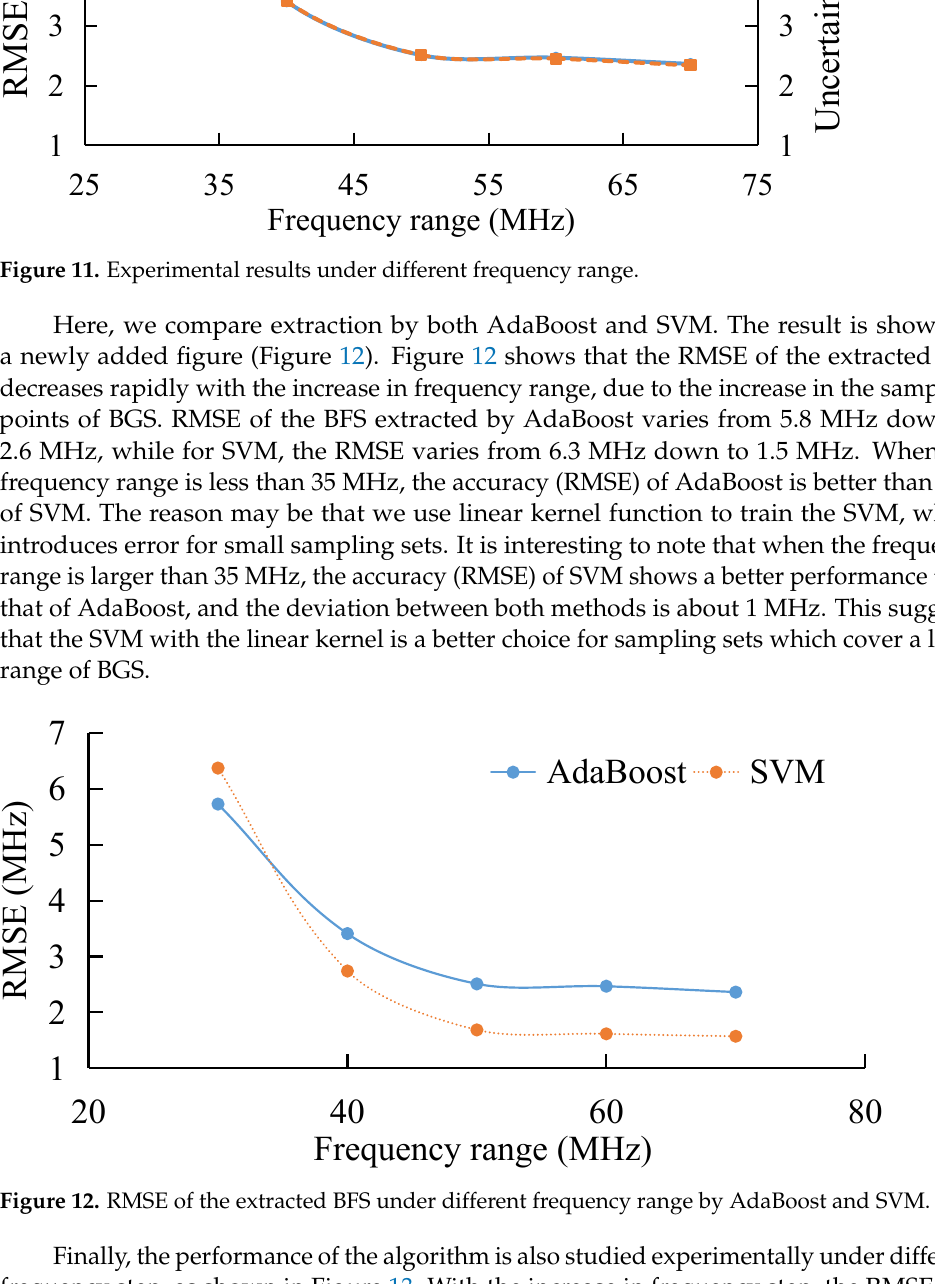
10 of 13 Figure 10. Experimental results under different cut-off frequency.